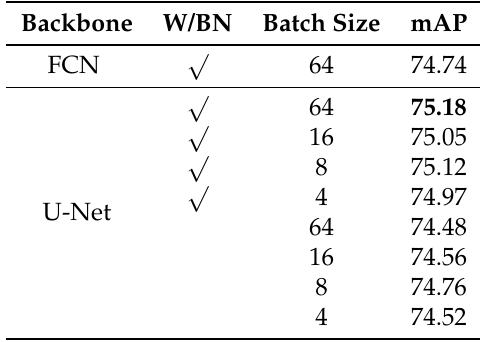
Table 5. Comparison of models trained with different configurations. All models were trained